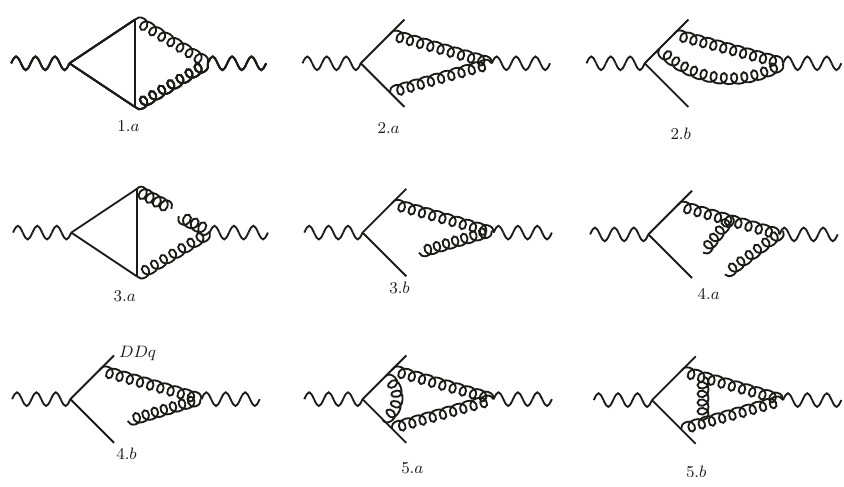
Figure 2 . Feynman diagrams for the (cid:22) qq -glueball mixed state. We omit most of the radiative correction diagrams which have been computed, and just list two of them at the end of the diagram terms. Note that 4.b just lists one expansion